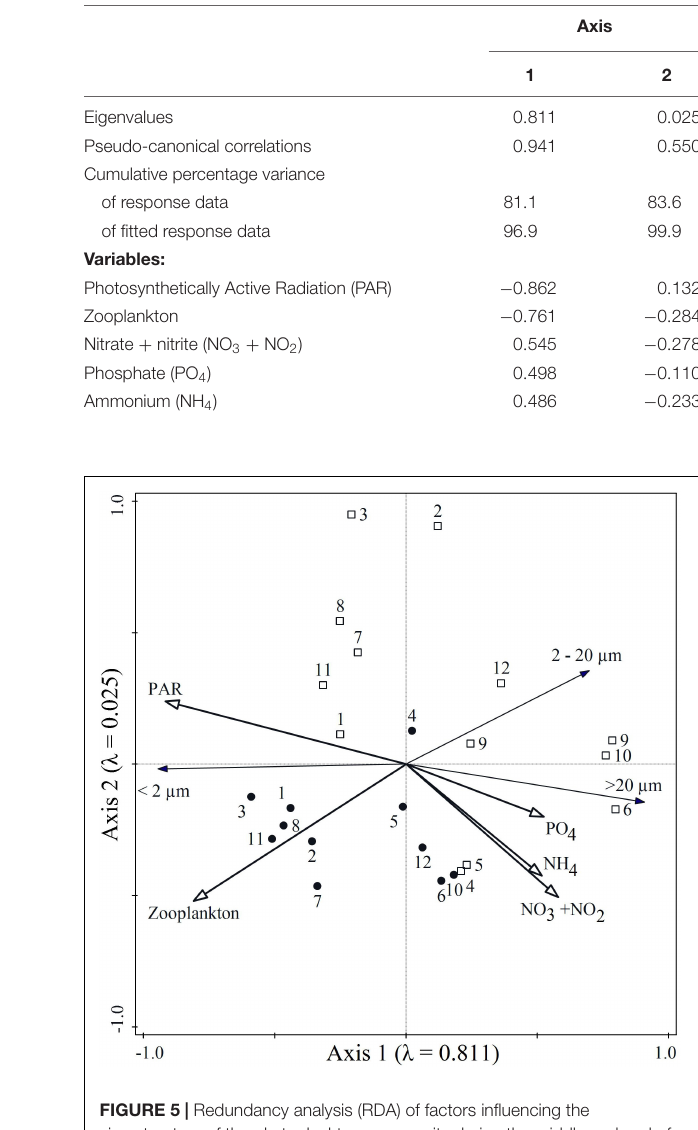
TABLE 3 | Variable loadings for the first and second axis of the RDA performed on biological and physicochemical data.